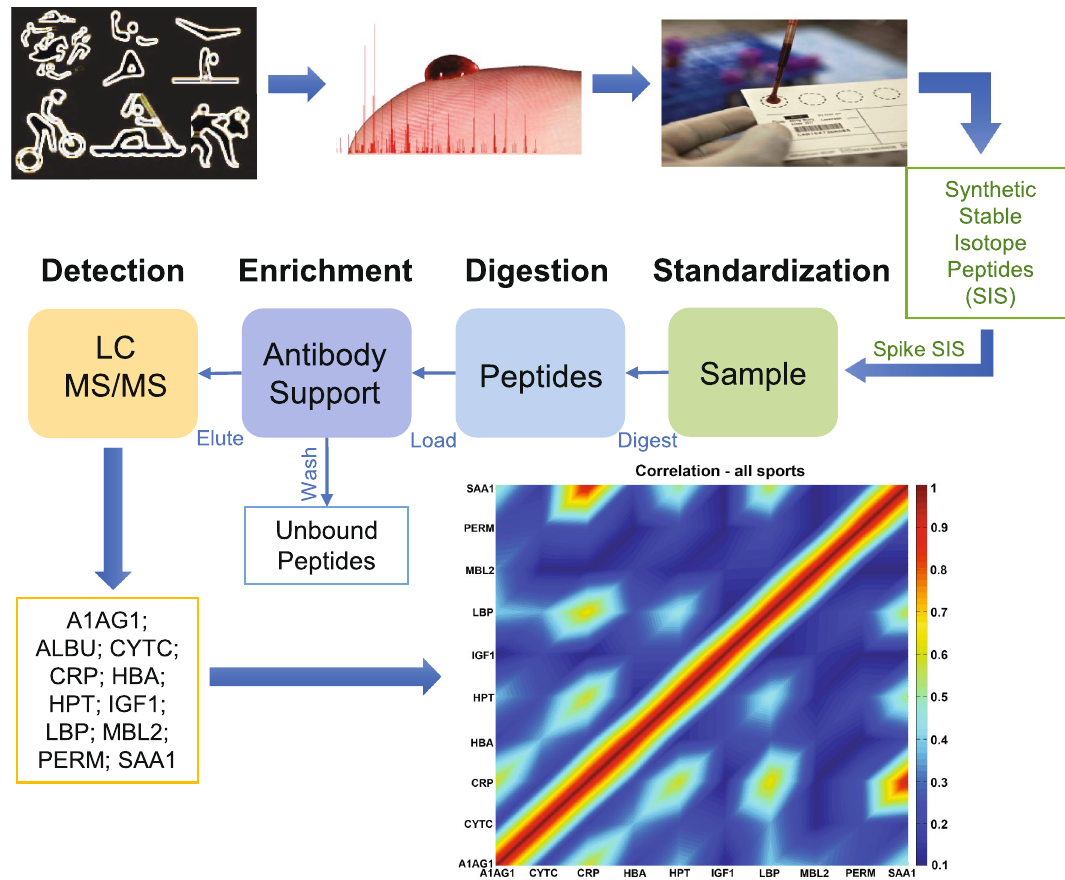
Figure 1. Experimental design. Analysis flowchart. Alpha-1-acid glycoprotein—A1AG1; Albumin—ALBU; Cystatin C—CYTC; C-reactive protein CRP; Hemoglobin beta chain—HBA; Haptoglobin—HPT; Insulin- like growth factor 1—IGF1; Lipopolysaccharide binding protein—LBP; Mannose-binding lectin—MBL2; Myeloperoxidase—PERM and Serum amyloid